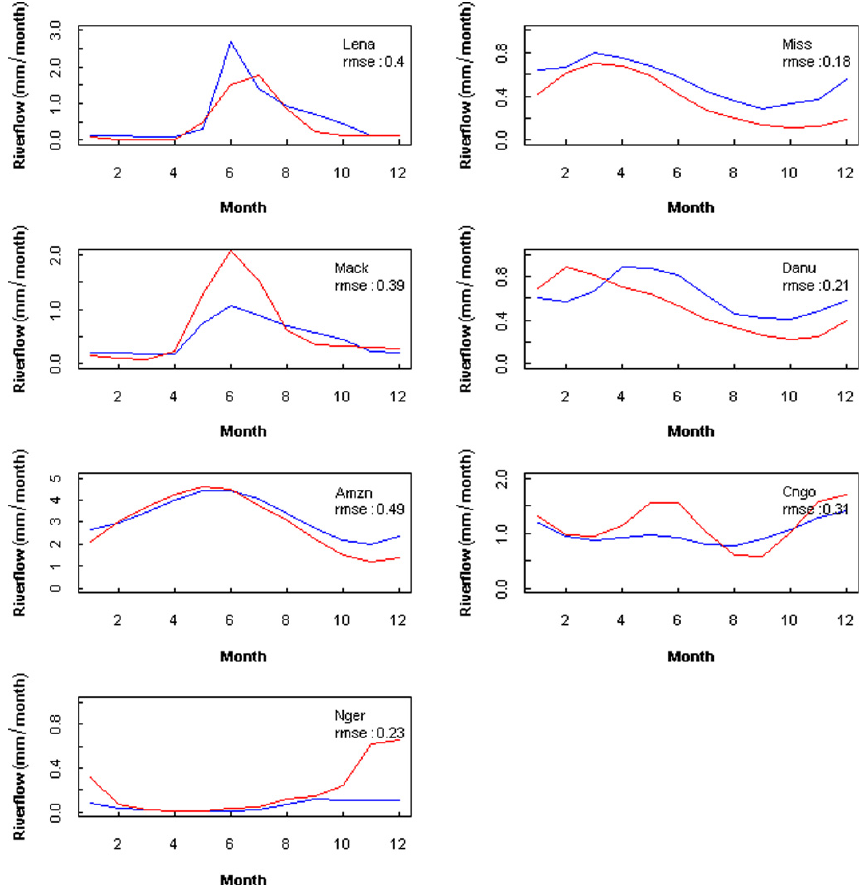
Fig. 6. Modelled (red) and observed (blue) seasonal river flow from 7 river catchments (Lena, Miss: Mississippi, Mack: Mackenzie, Danu: Danube, Amzn: Amazon, Cngo: Congo,